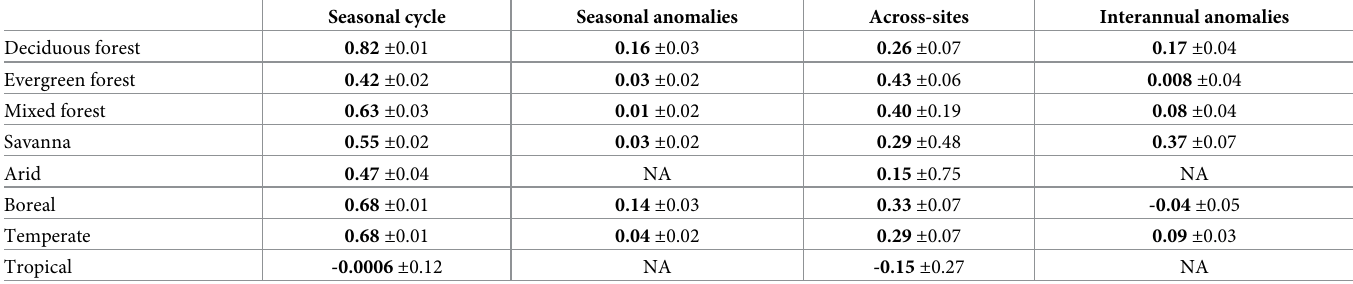
Table 3. Nash-Sutcliffe modeling efficiency of the LSTM setup per vegetation type and climate region from the ensemble mean ± sd estimate of the 50 runs. Statistics for the anomalies were not calculated in the arid and tropical climate (i.e. NA) because there was no site with at least 3 years of complete data after data quality control. Savanna vegetation type includes both savanna and woody savanna sites.